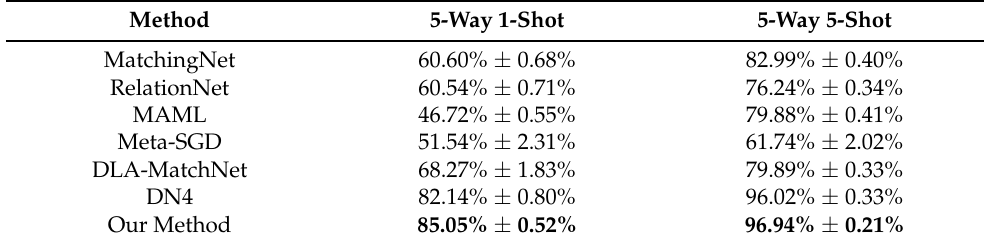
Table 4. Experimental results of different methods on the WHU-RS19